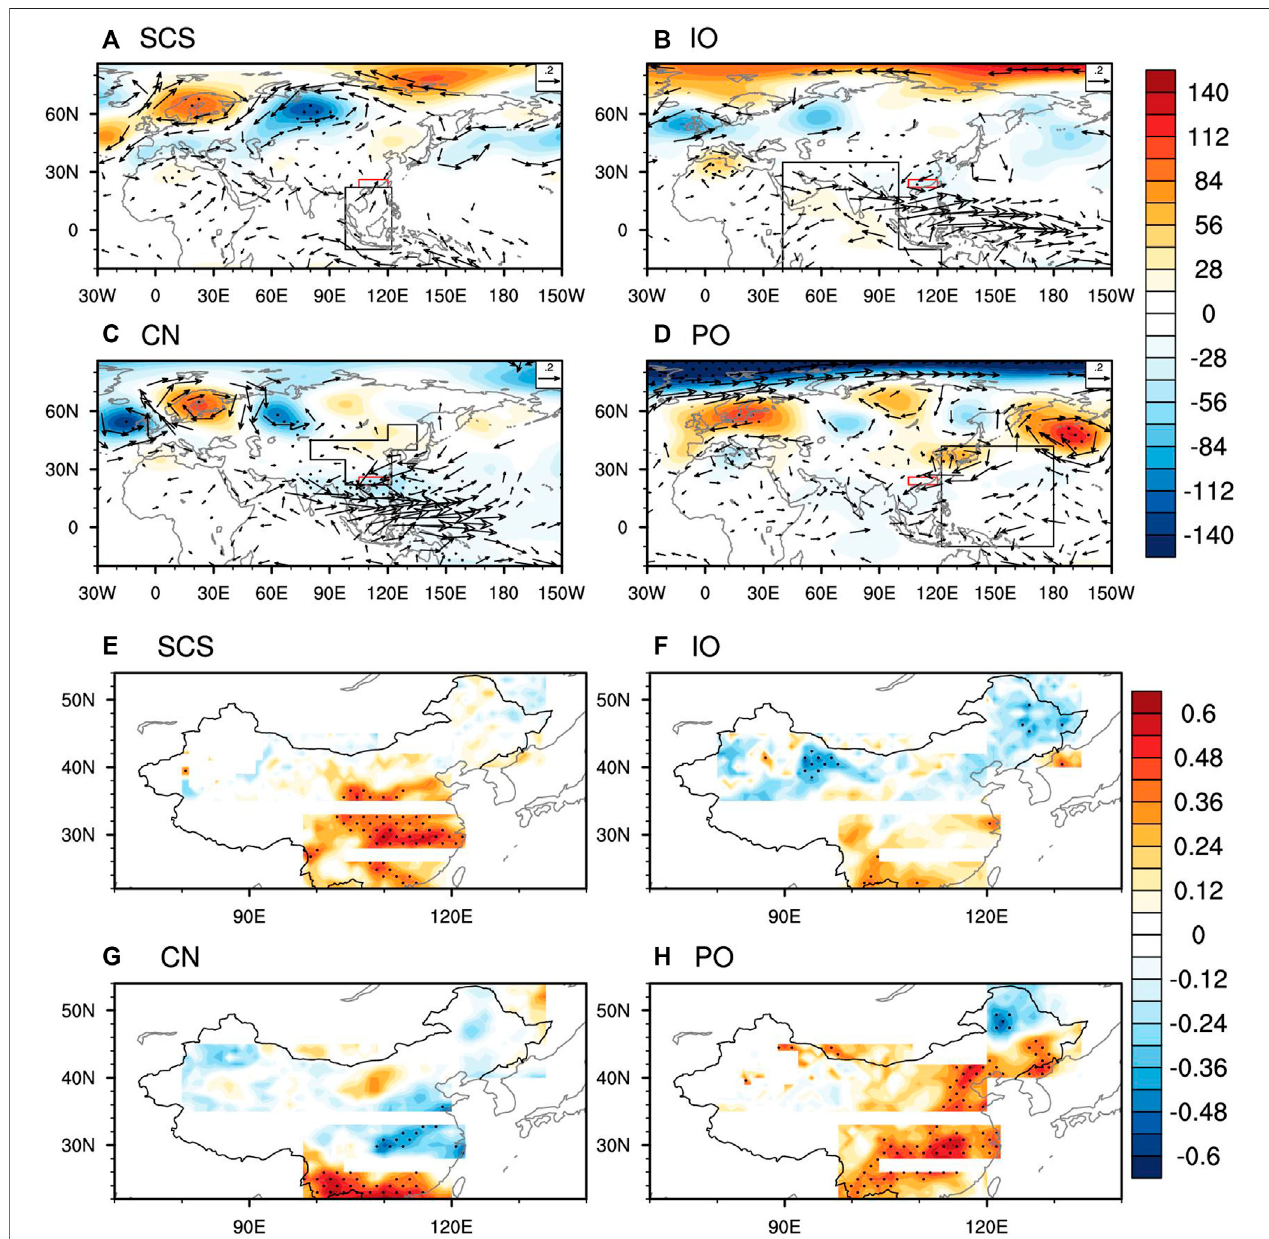
FIGURE 9 | As in Figure 5 but for SC. Panels (A – D) show circulation anomalies regressed against the SCS, IO, CN and PO moisture sources. Panels (E – H) show the SCS source precipitation anomalies correlated with the WNPSH index, the IO source with the reversed ISM index, the CN source with the reversed WNPSH index, and the PO source with the PJ